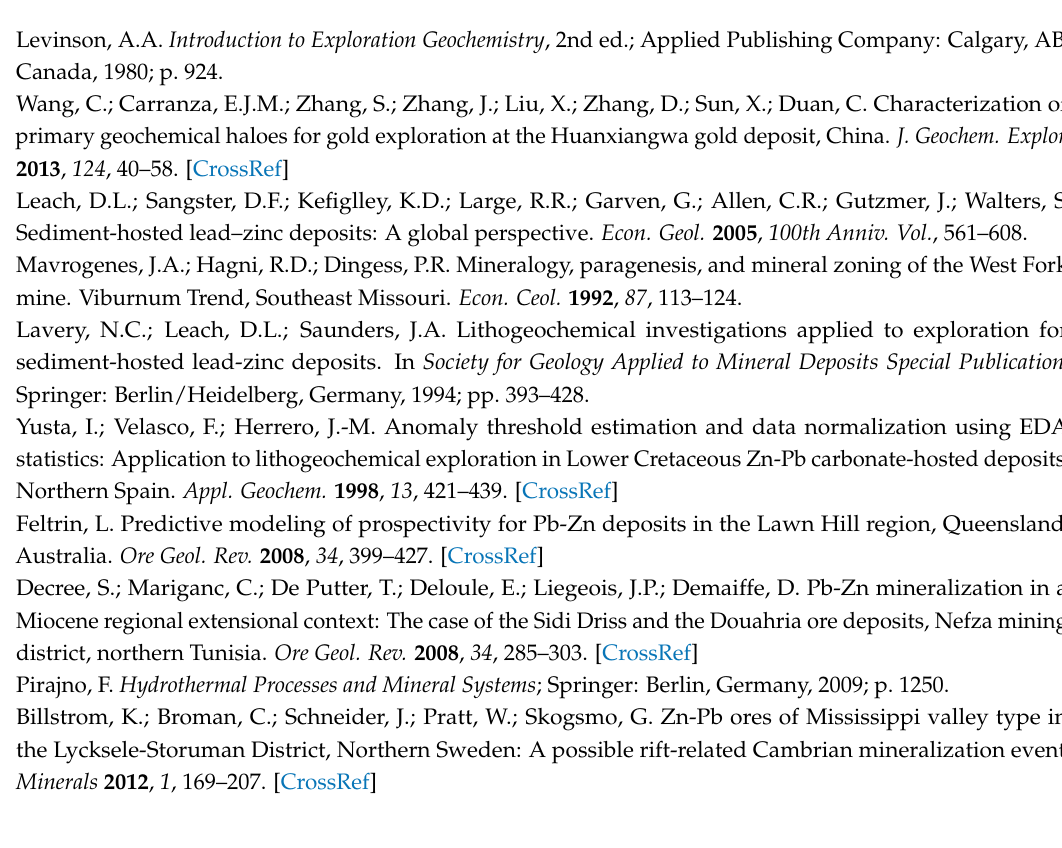
Figure S1: (a) Scree plot of parallel analysis (eigenvalues Mont-Carlo simulation) using PCA on CLR from the surface samples in Block A of the Ravanj deposit. Eigenvalues upper than raw data line are significant. (b) Biplot of PC1 vs. PC2. (c) Biplot of PC2 vs. PC3. (d) Biplot of PC3 vs. PC4, Table S1: Results of Robust PC analyses of surface samples from Block A of the Ravanj deposit (using the broken-stick method, [45]). Extraction Method: Principal Component Analysis. Rotation Method: Varimax with Kaiser